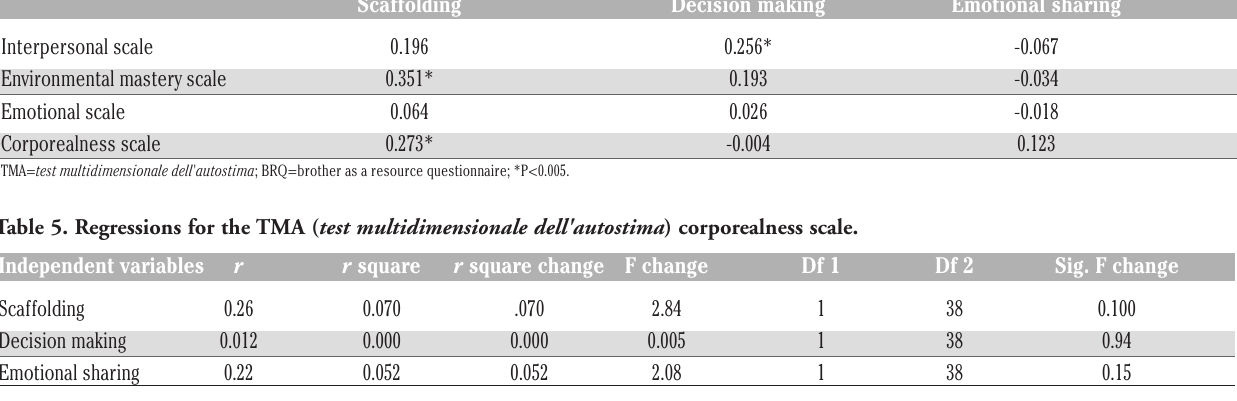
Table 4. Correlations between indicators of self-esteem and indicators of the relationship perception with brothers (Pearson Correlation) in the experimental group (N=40). Indicators of self-esteem (TMA)